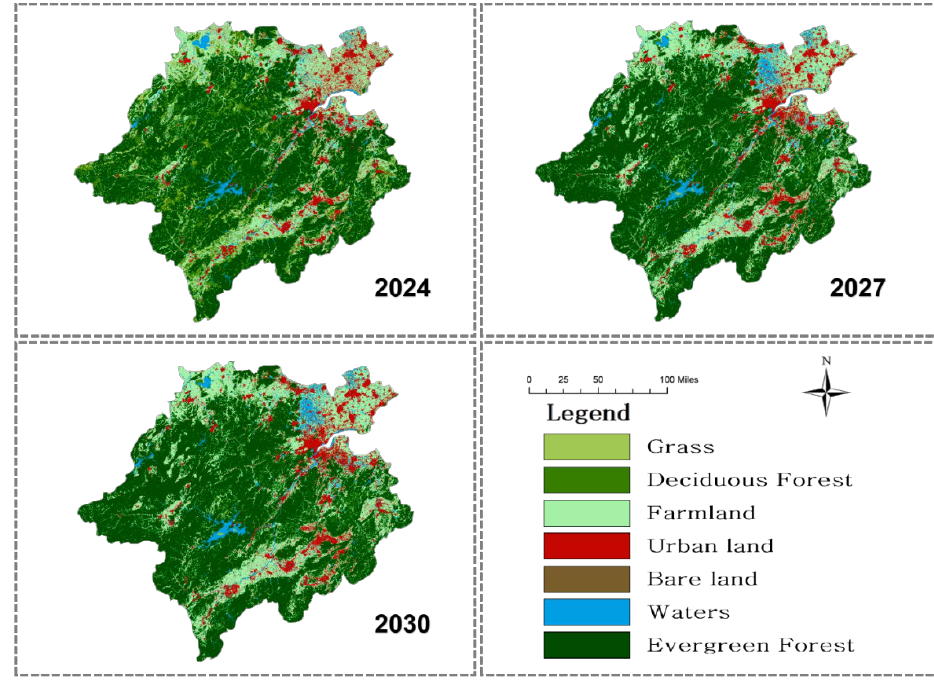
Figure 11. Simulation of land use types in 2024, 2027, and 2030.